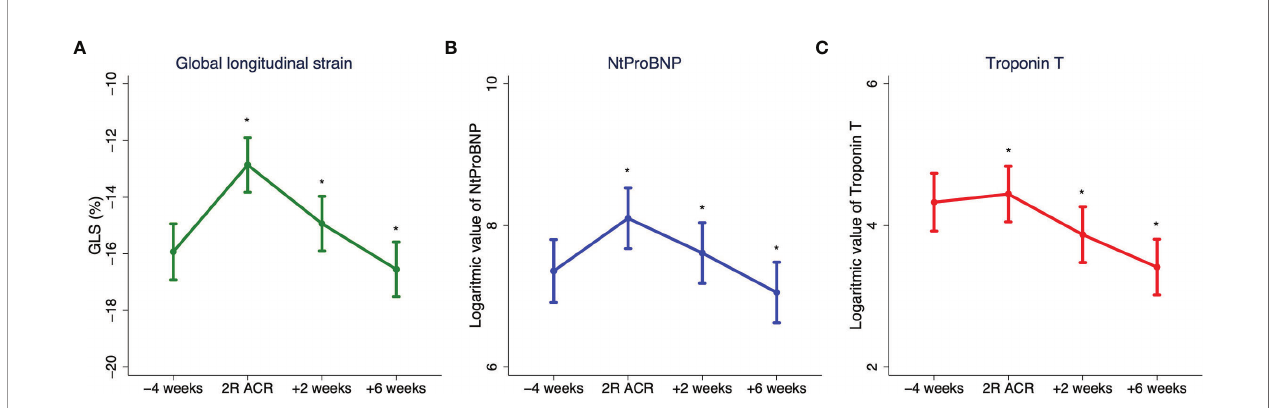
FIGURE 3 | Margin plots with 95% con fi dence interval demonstrating changes in (A) echocardiographic left ventricular global longitudinal strain (GLS) magnitude, plasma NT-ProBNP level, and (B) plasma high-sensitivity Troponin T level (C) before, during, and after treatment demanding rejection ( ≥ 2R). “ *signi fi cant difference (p<0.05) compared with